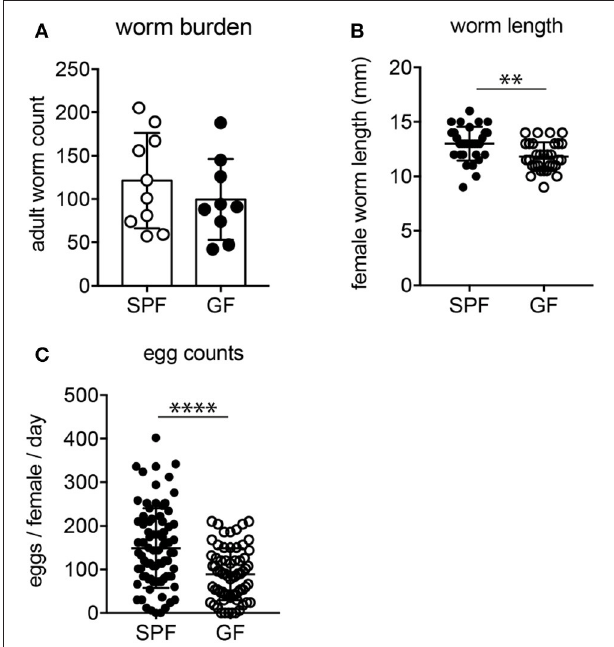
FIGURE 3 | Parasite burden and fitness in SPF and GF mice. (A) Number of luminal adults isolated 2 weeks post- H. polygyrus infection from SPF and GF mice. (B) Length of female parasites. (C) Fecundity of female worms determined as egg production within 24h after isolation. Data are pooled from two independent experiments each performed with four to five infected mice per group. Mean, SD, and individual data points are shown. ** p < 0.01, **** p <